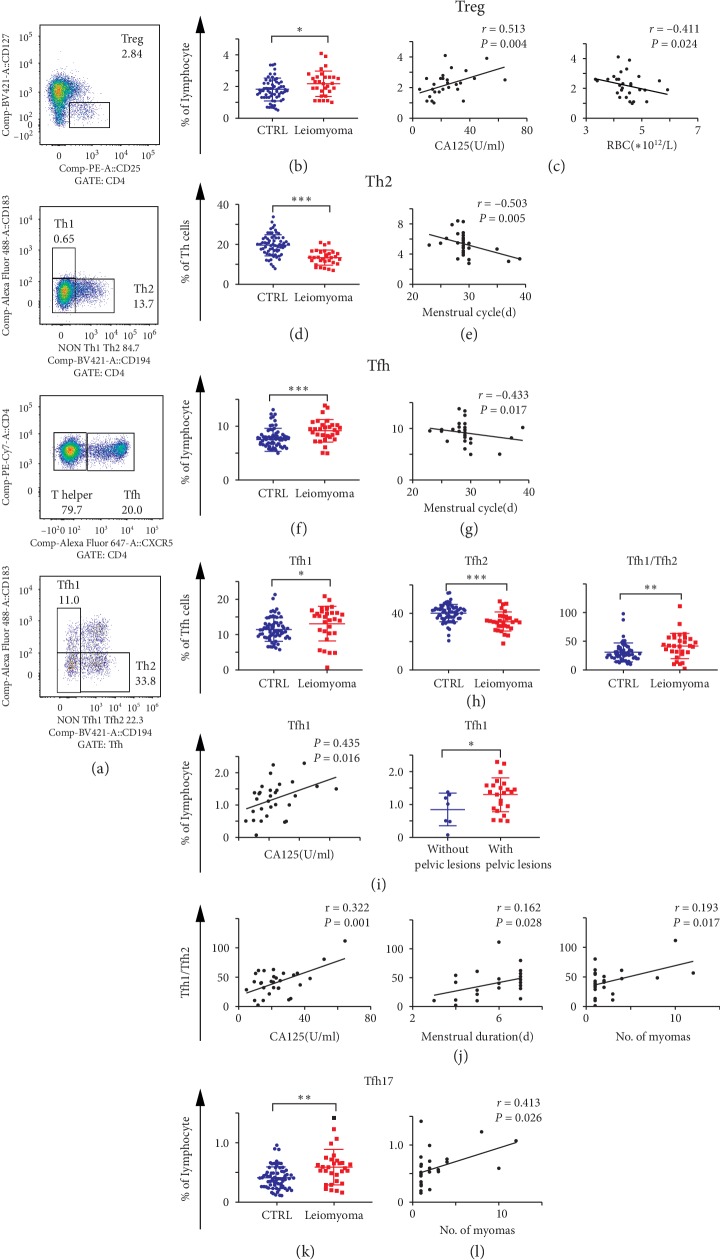
Distribution characteristics and significances of the Treg, Th, and Tfh cells in 30 leiomyoma patients and 68 controls. (a) The flow analyses of regulatory T (Treg), helper T (Th), and follicular helper T (Tfh) cells. (b, d, f, l) The comparison of above cells between patients and controls. (c) The correlations of Treg cells with CA125 and red blood cells (RBC), respectively. (e, g) The associations of Th2 and Tfh cells with menstrual cycle, respectively. (j) The association between Tfh1 cells with CA125 and pelvic diseases, respectively. (k) The association between the ratio Tfh1/Tfh2 with CA125, menstrual duration, and the numbers of myomas in each case. (l) The association between Tfh17 cells with myoma number. ∗P < 0.05. ∗∗P < 0.01. ∗∗∗P < 0.001. ns, not significant.